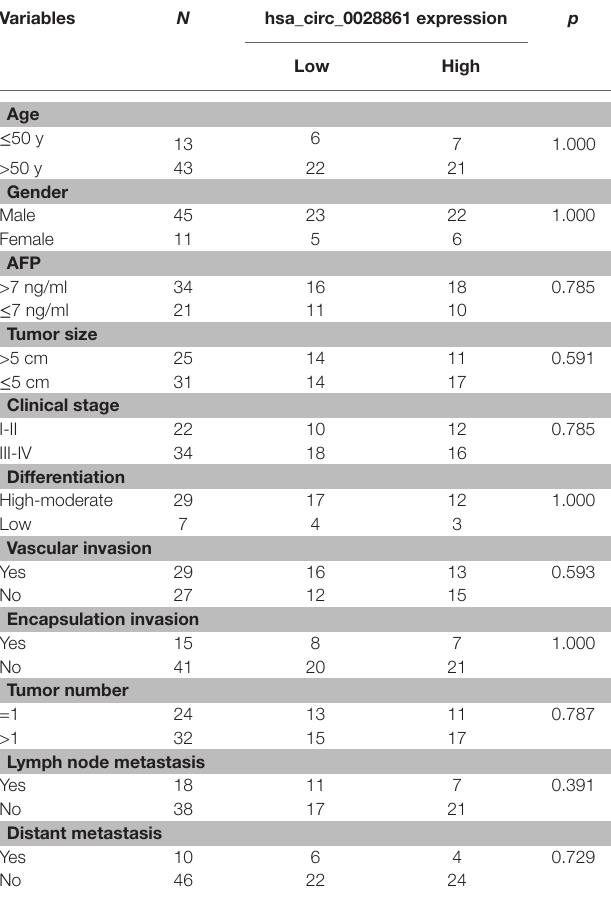
hsa_circ_0028861 in serum exosomes from HCC patients.